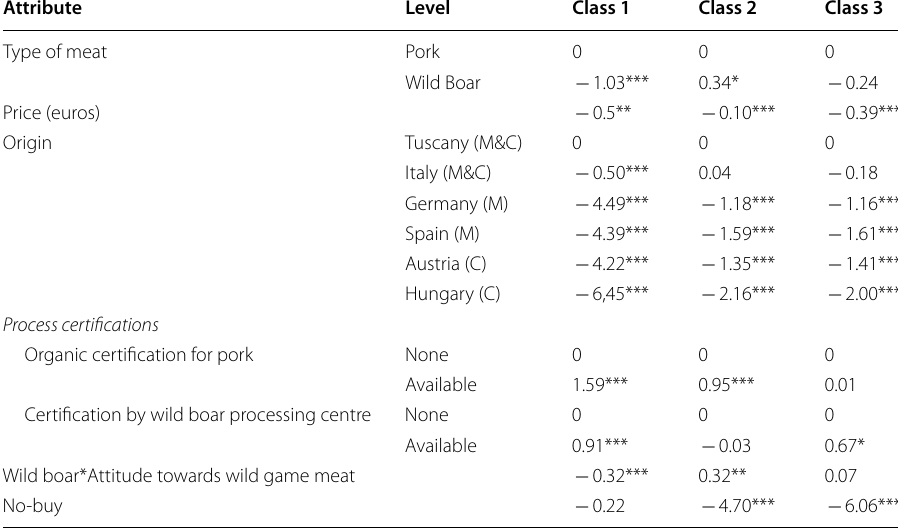
*indicates a significance of 90%, **of 95% and ***of 99%. Within the levels of origin M C exclusive level of origin of wild boar, M&C =